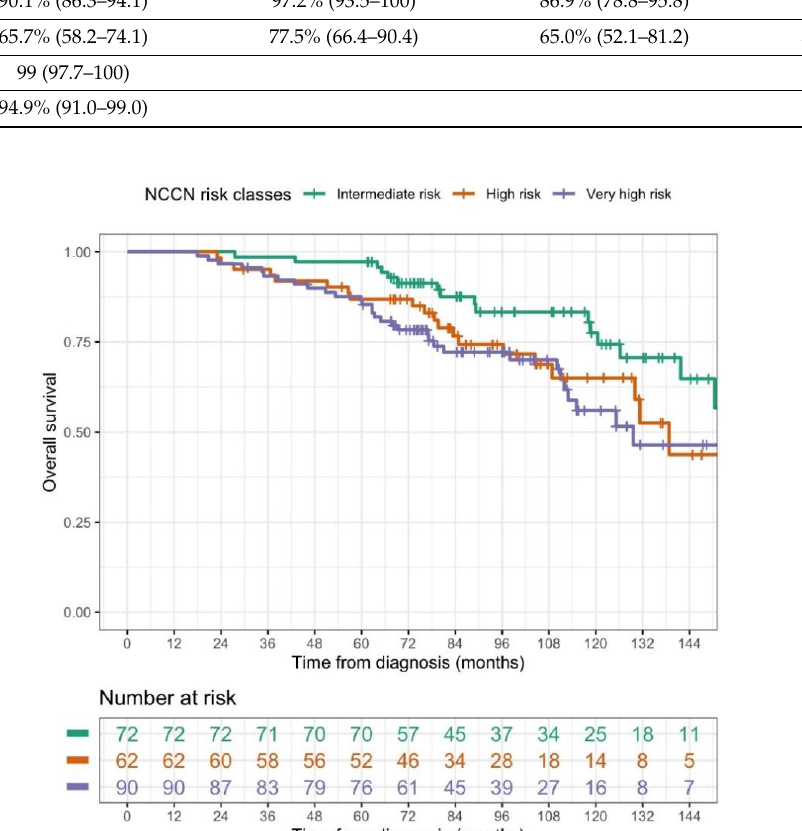
Figure 1. Kaplan–Meier estimates of overall survival (OS, computed from the diagnosis) in the three NCCN risk classes ( p = 0.096, log-rank test; NCCN risk class VHR vs. NCCN risk class UIR, HR = 1.8792, 95% CI: 1.0509–3.3604, p = 0.03338, univariate Cox regression model). Although all the data